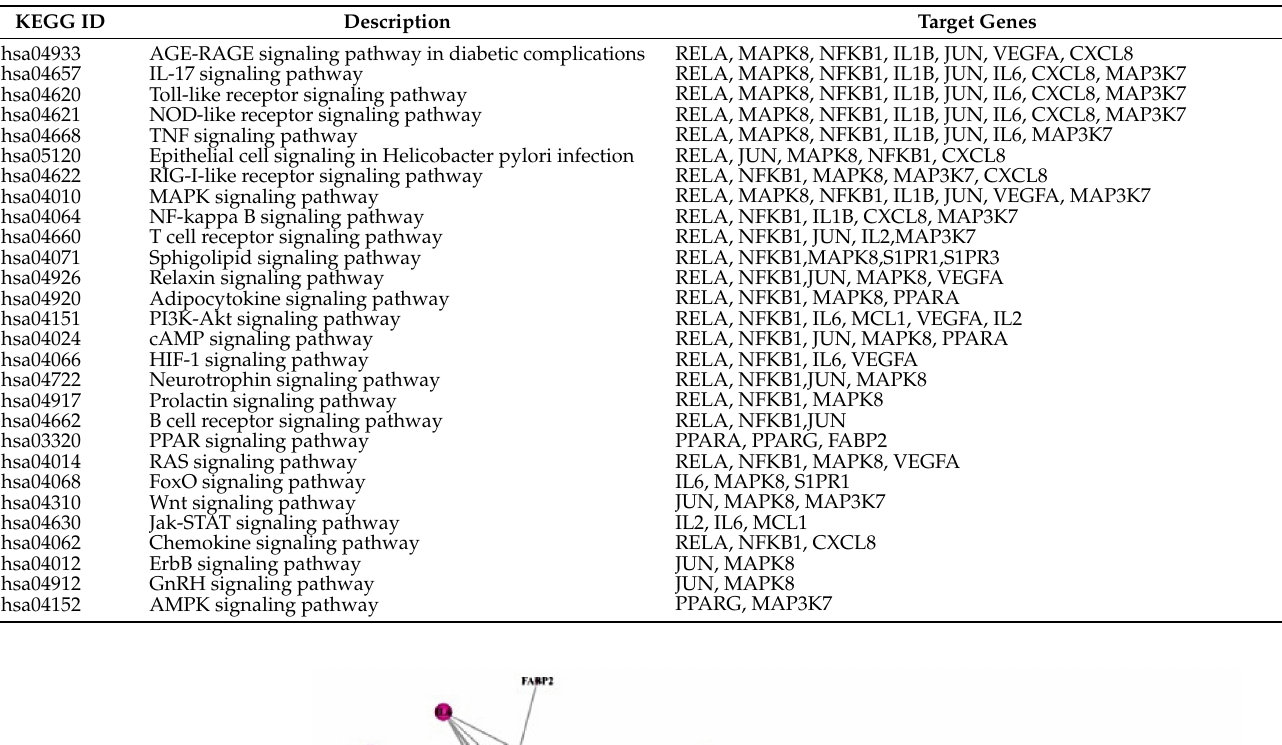
Table 2. Target genes in 28 signaling pathways enrichment related to COVID-19.